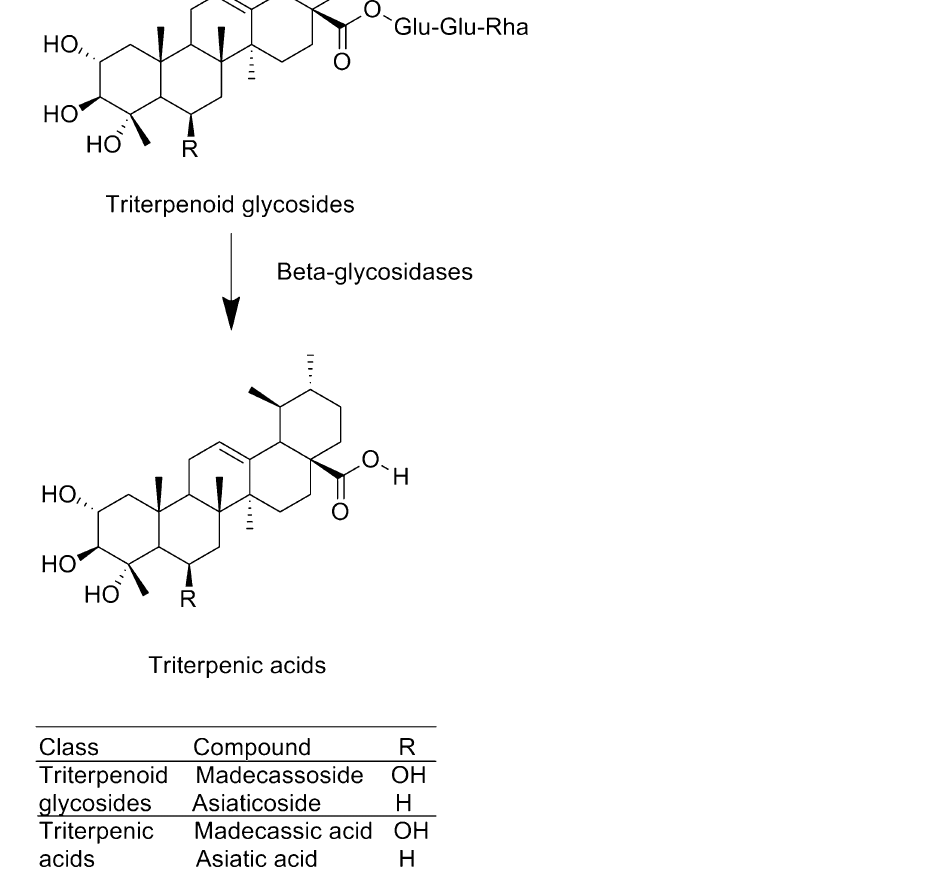
Figure 1. Chemical structure of bioactive triterpenoids in standardised extracts of Centella asiatica